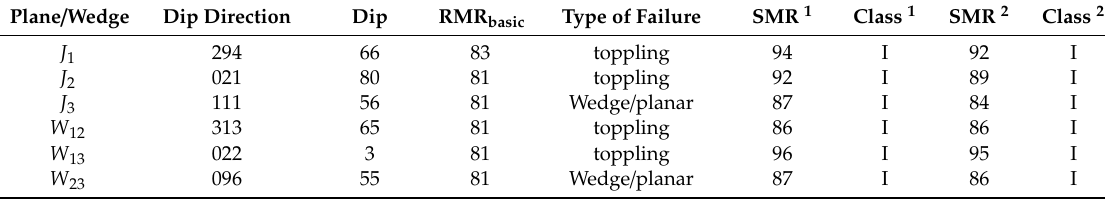
Table 4. Evaluation of SMR parameters of the discontinuity sets and formed wedges at sector 1. Plane / Wedge